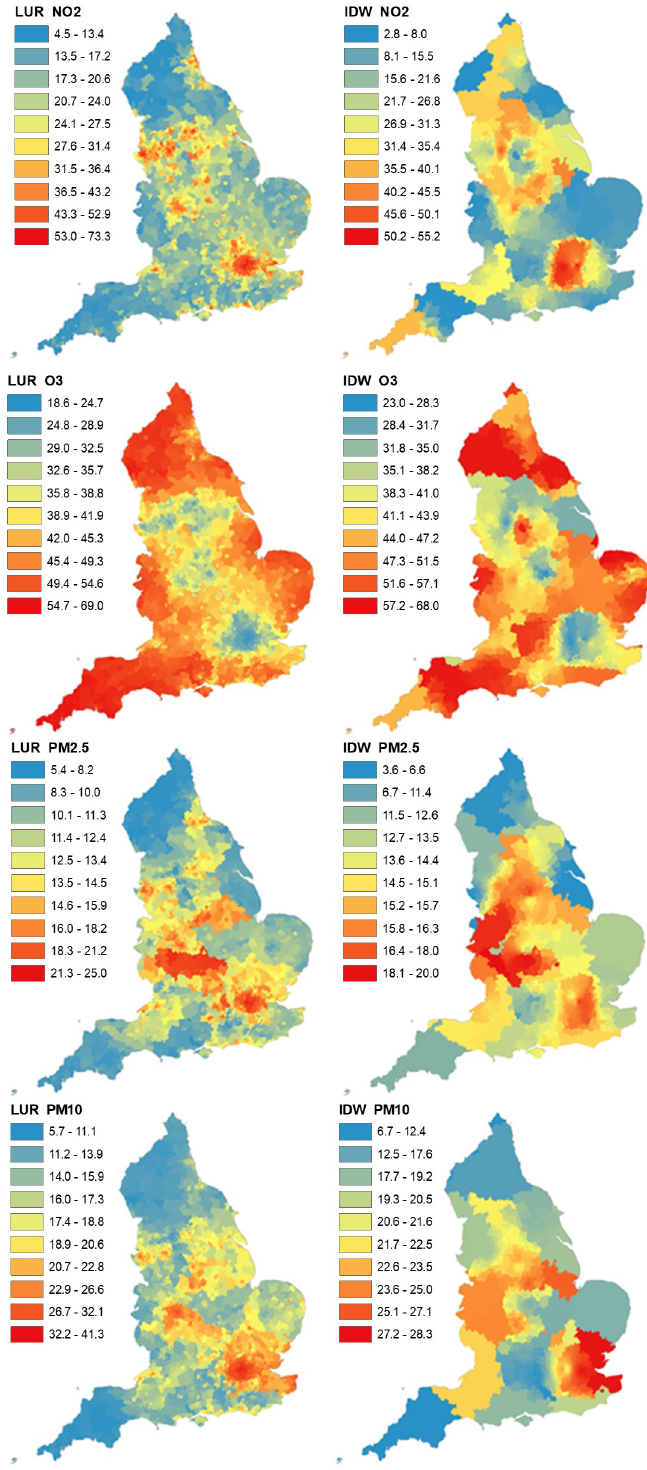
Figure A1. Annual average air pollution concentrations of the LUR model across England, over the year of interest, at the postcode district level ( left ); annual average of IDW of one to four nearest monitoring stations at the postcode district level ( right ). Concentration displayed in µgm − 3